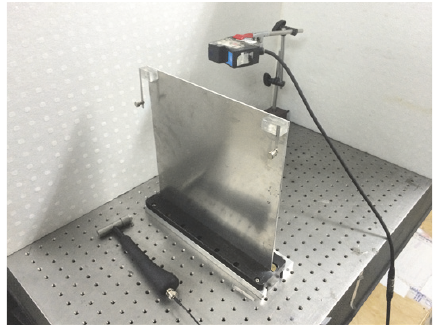
Figure 11: TMD experimental